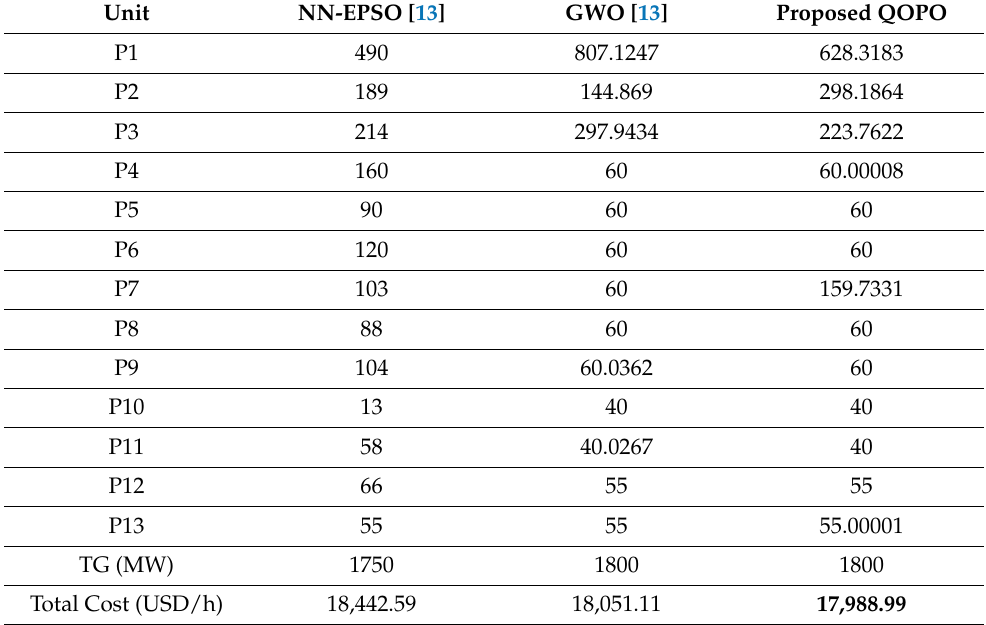
Table 3. Comparison of power distribution among 13 units for the load demand of 1800 MW.